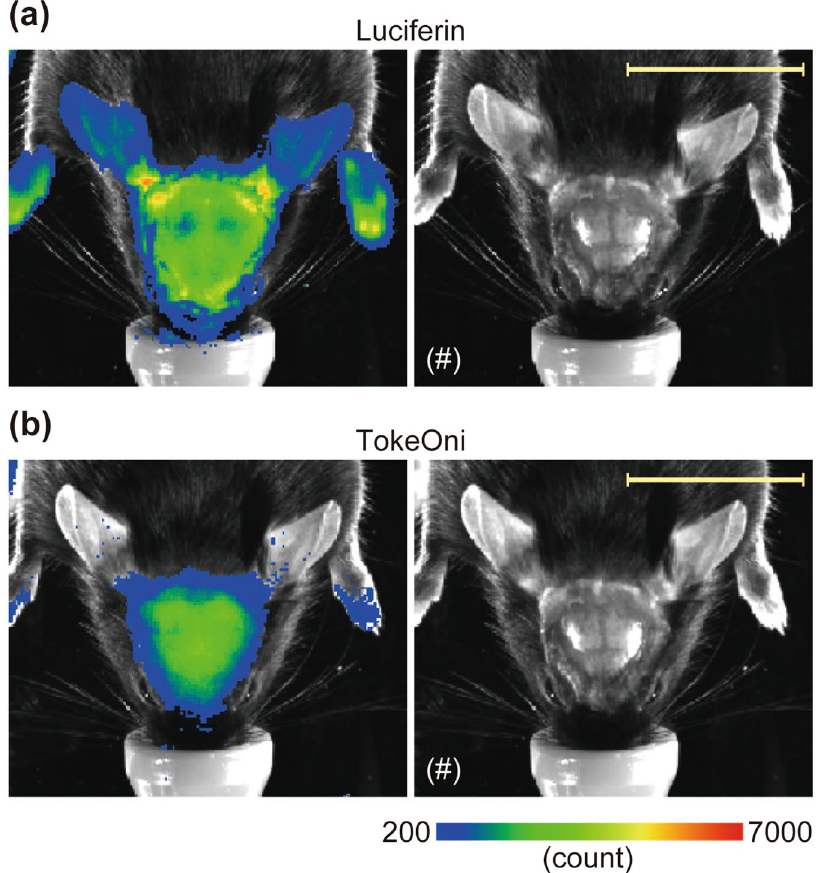
Figure 4. Comparison of the bioluminescence signal obtained by d-luciferin and that by an analogue of d-luciferin, TokeOni. The bioluminescence was first measured using d-luciferin ( a ). Three hours after the measurement, the bioluminescence was re-measured using TokeOni ( b ). These substrates were administered to the Tg mice intraperitoneally at the same dose (150 mg/kg body weight) and under the same conditions (Exposure: 2 min). The photograph of the head region of the Tg mouse (indicated by (#)) was merged with the pseudocolored image. Scale bar = 20 mm. The experiment was performed independently at least three times, and the same tendency was